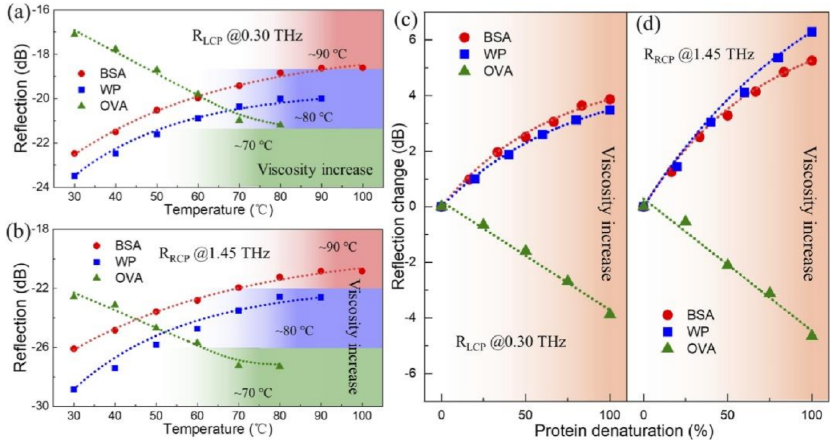
Figure 6. ( a ) The peak values of the R LCP and ( b ) R RCP of BSA, WP and OVA solutions change as a function of the heat-treatment temperature. The temperatures, reported in these two figures, refer to the temperature of the complete denaturation for a certain protein. Relationship of the peak value change of ( c ) R LCP and ( d ) R RCP vs. the denaturation percentage. Reprinted from Ref.